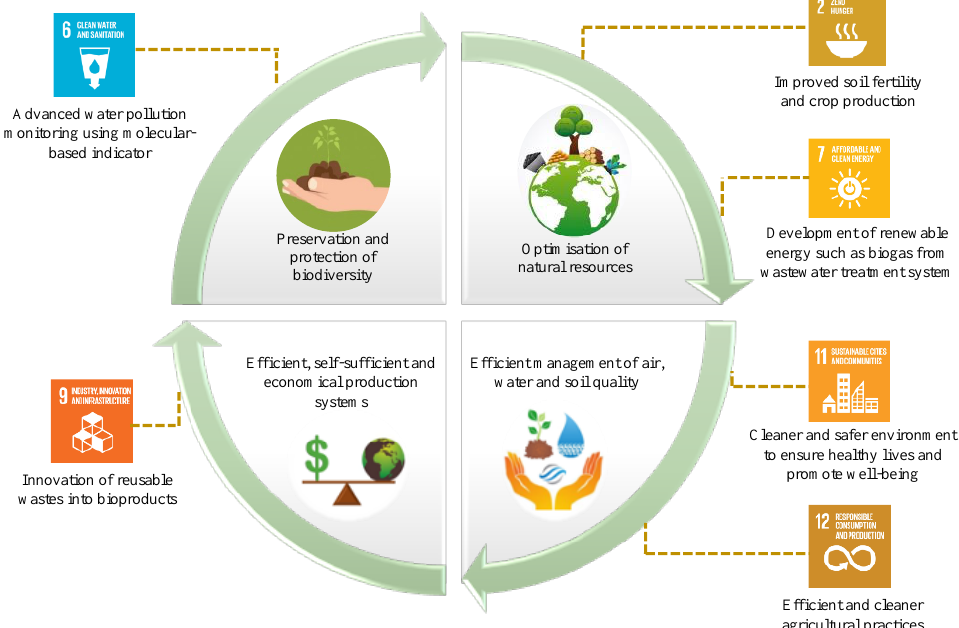
Figure 1. Advancing the key principles of sustainable industrial agriculture and related Sustainable Development Goals (SDGs) through microbiome-based innovations.